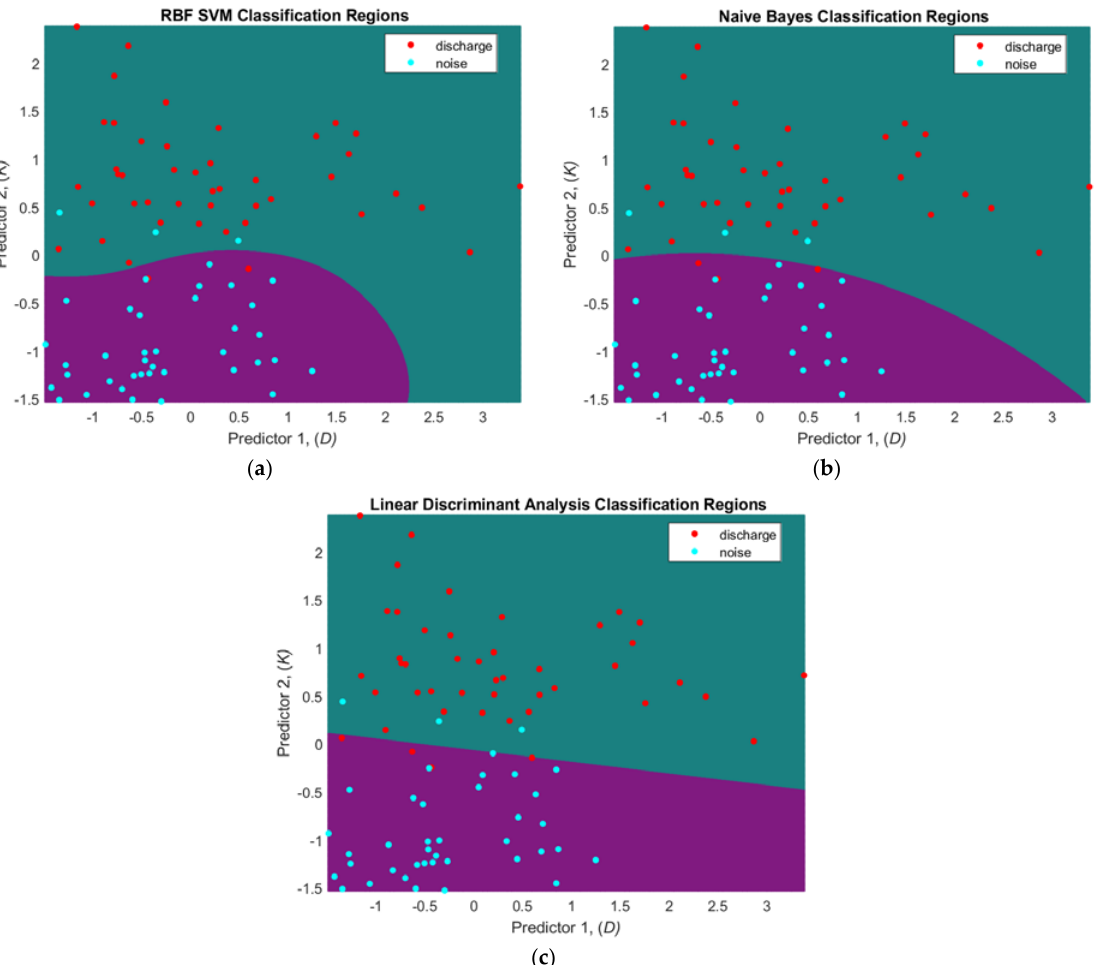
Figure 5. The classification boundaries of discharge and noise datasets obtained using two feature vectors and following classifiers: ( a ) RBF SVM; ( b ) Naïve Bayes (NB); ( c ) Linear Discriminant Analysis (LDA).